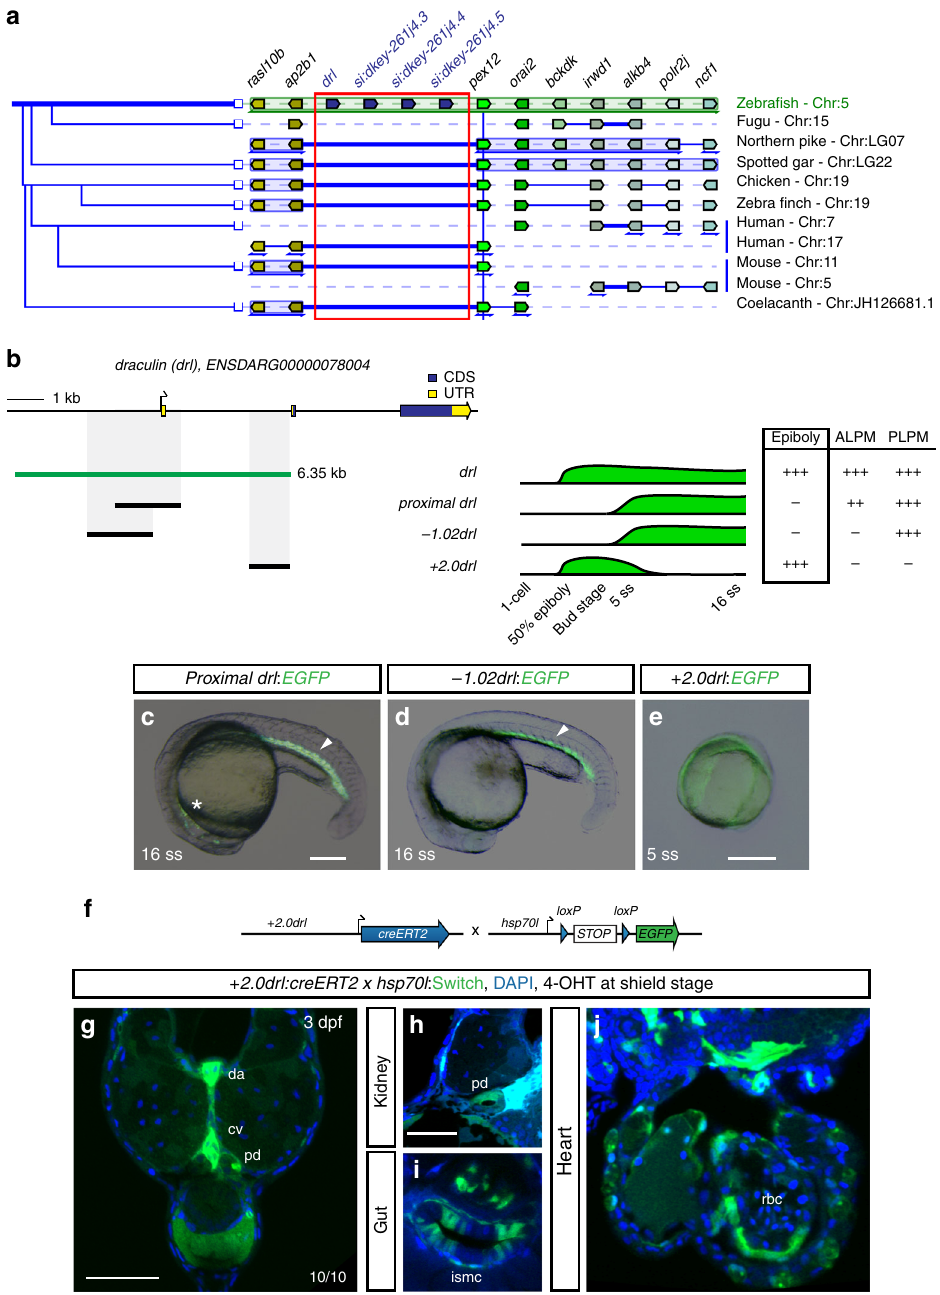
Fig. 3 The 6.35 kb drl cis -regulatory region contains an early pan-LPM enhancer. a Adapted Genomicus-based PhyloView representation of the zebra fi sh drl locus (top row) compared to other vertebrate species. The view is centered on pex12 (light green, blue vertical line) as anchor, with its orthologous copies across species and corresponding neighboring loci shown by their relative positions. Genes with identical coloration are homologs/orthologs. Blue arrows below gene loci indicate switched local orientation. The phylogenetic relationship tree is depicted on the left. The red box marks the drl locus with its neighboring three drl -related genes (blue) in between ap2b1 and pex12 in zebra fi sh as unique feature. Note the absence of any genes between ap2b1 and pex12 orthologs across fi shes and other vertebrates, and conservation of suggested ancestral synteny of ap2b1 and pex12 . b Schematic of the drl locus depicting the 6.35 kb cis -regulatory region (green), and smaller isolated candidate fragments proximal drl (region surrounding fi rst exon), − 1.02drl (upstream region only), and + 2.0drl (distal fi rst intron) with speci fi c reporter activity. Time line and table indicates expression dynamics (50% epiboly to 16 ss) of stable transgenes for the individual regulatory elements and expression domains (pan-LPM early or somite-stage ALPM, PLPM) with absent expression (-) to strong expression ( + + ). c – e Representative stable transgenic zebra fi sh embryos harboring EGFP reporters for proximal drl, − 1.02drl , and + 2.0drl ; at 5 ss and 16 ss proximal drl and − 1.02drl express in PLPM (arrowheads in c , d ), proximal drl additionally in ALPM (asterisk in c ); note pan-LPM activity of + 2.0drl ( e ). f Schematic of + 2.0drl:creERT2 to hsp70l:Switch cross for genetic lineage tracing. g – j Transverse sections at 3 dpf of + 2.0drl:creERT2 lineage tracing after 4-OHT induction at shield stage results in speci fi c labeling of LPM-derived tissue including red blood cells (rbc), dorsal aorta (da) and cardinal vein (cv) endothelium, pronephric duct (pd), and intestinal smooth muscle cells (ismc) ( n = 10/10). + 2.0drl:creERT2 also traces endoderm-derived tissue, shown for gut epithelium. Nuclei counterstained with DAPI (blue). Scale bars ( c , e , g ) 250 µ m and ( h ) 50 µ